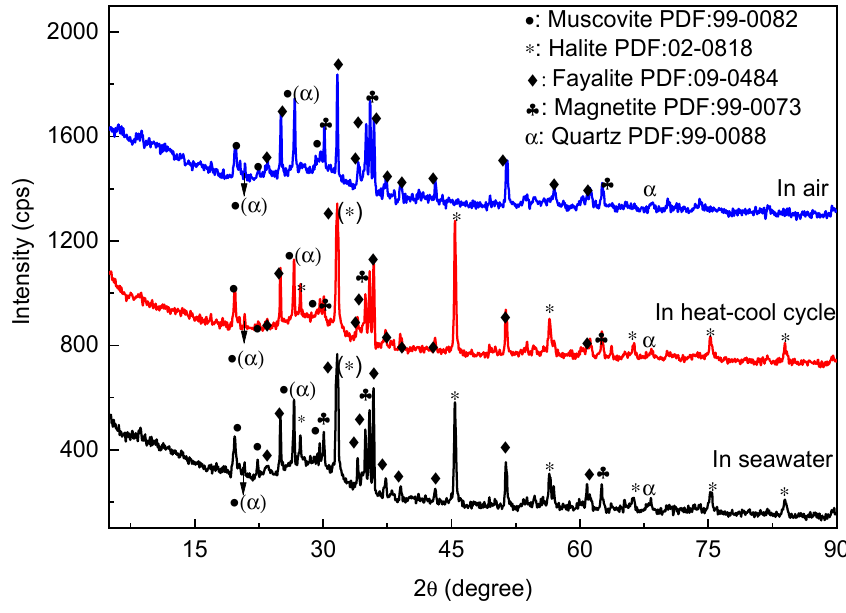
Figure 4. XRD spectra of the geopolymers prepared with 60% metakaolin.